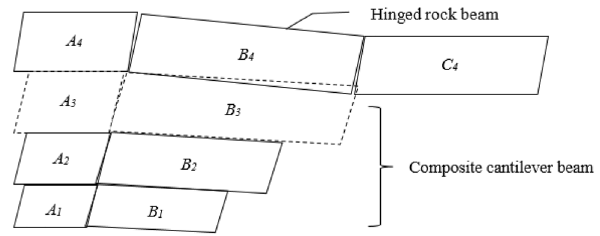
Fig. 1 Morphological structure of a composite cantilever beam and hinged rock beam in small periodic weighting